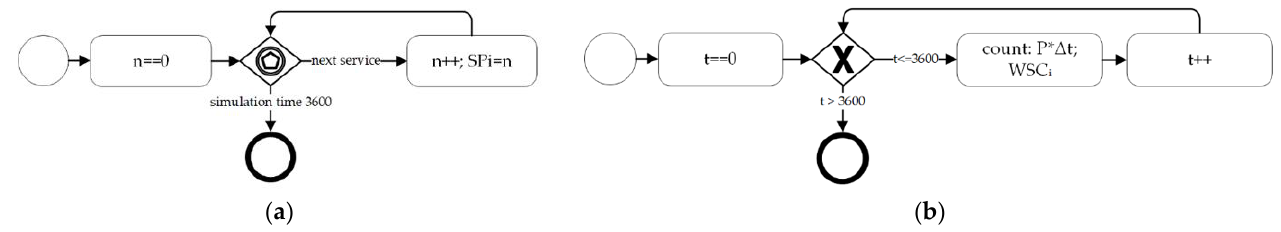
Figure 4. Simplified algorithm for calculating output variables: ( a ) system performance, ( b ) power consumption.